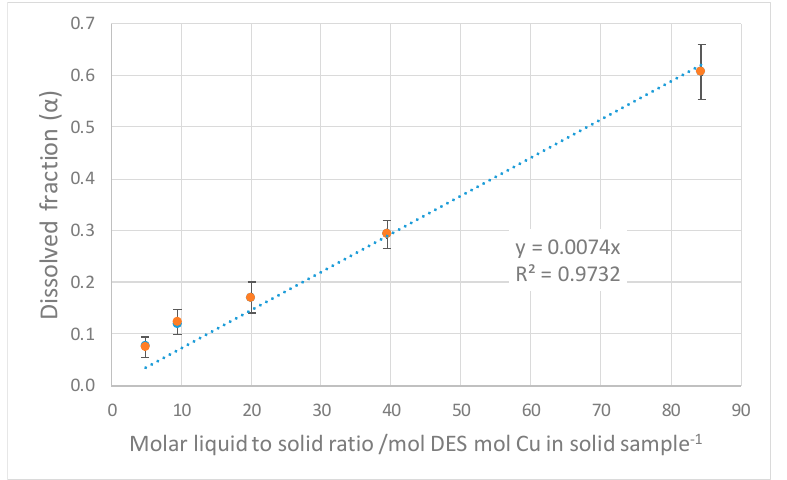
Figure 2. Final dissolved fraction as a function of the ratio between deep eutectic solvent molar content to molar copper content in chalcopyrite solid. Dissolution time: 240 min; Temperature: 50 °C.